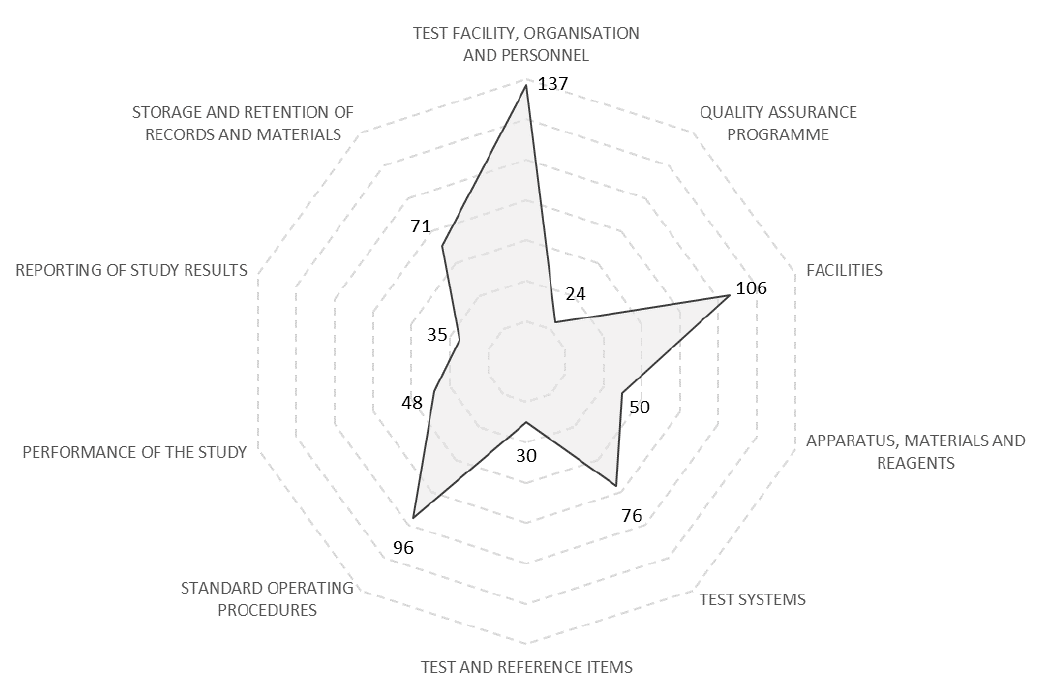
Figure 1. Number of GLP-related activities undertaken at the test facility allocated to the sections within the SANAS checklist. Unique GLP-related activities undertaken at the test facility were collated and allocated to the sections within the checklist used by the South African National Accreditation System checklist to audit GLP studies. Each axis in the radar chart represents a different section within the checklist, and the number of activities that were undertaken that relate to that section is charted. Very few activities were undertaken realted to the Quality Assurance programme, Test and Reference Items, and Reporting of Study Results. Many activities were undertaken related to the Test Facility Organisation and Personnel, Facilities, and Standard Operating